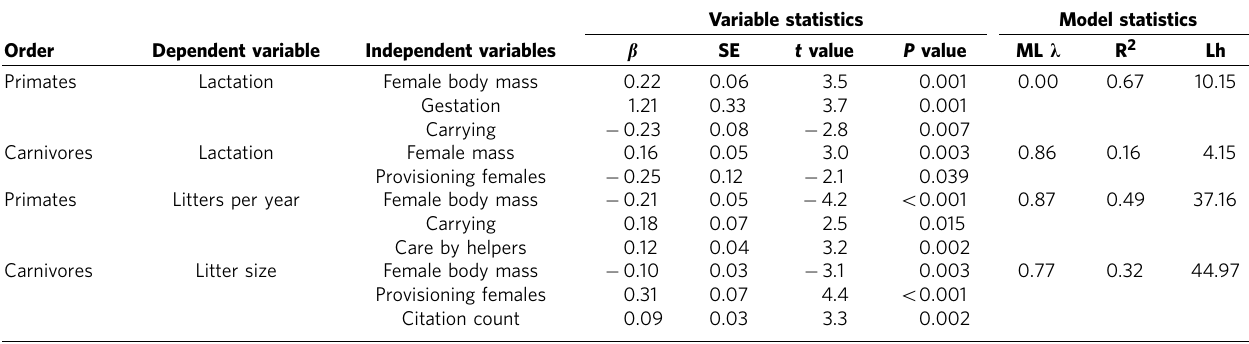
Table 2 | Reduced PGLS multi-predictor models for lactation time, litters per year and litter size with significant individual behaviours within